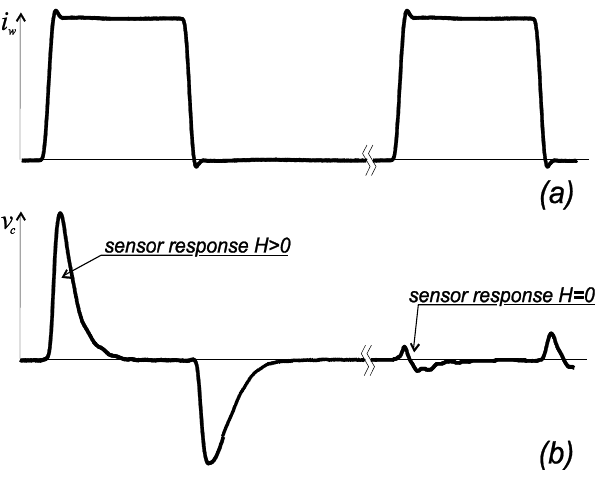
Figure 10. Excitation current pulse in the wire (a) and voltage induced in the pickup coil